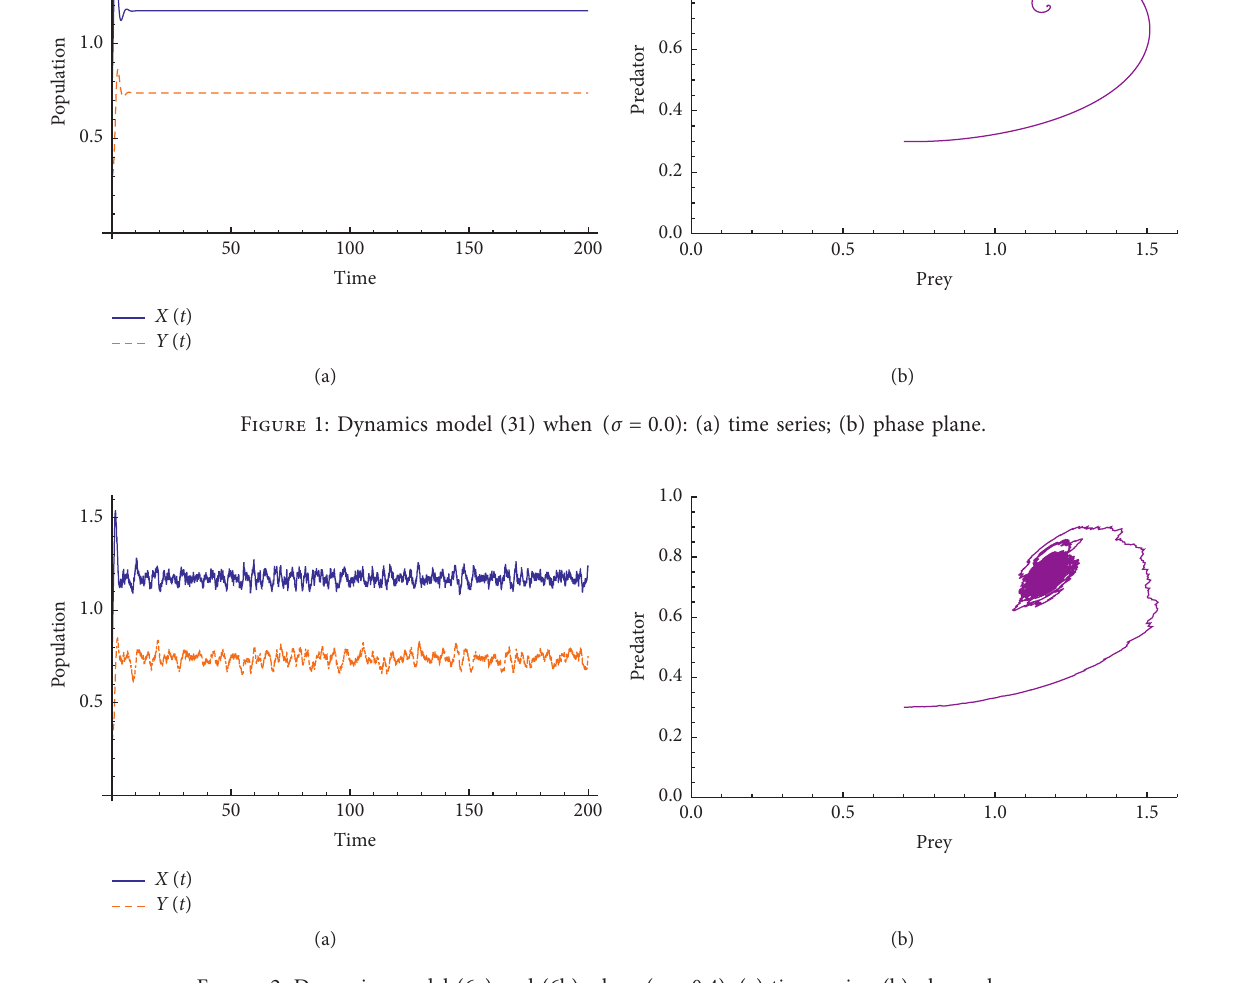
Figure 2: Dynamics model (6a) and (6b) when ( σ � 0 . 4 ) : (a) time series; (b) phase plane.